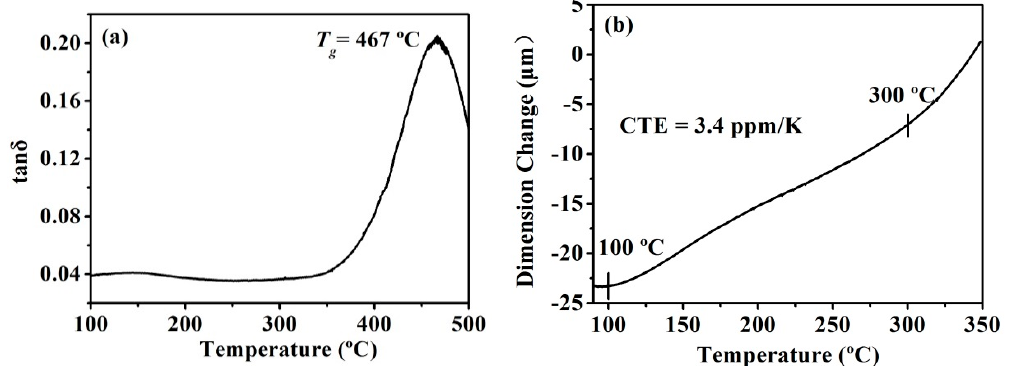
Figure 3. ( a ) DMA and ( b ) TMA curves of the 2,7-CPI film. Table 1. Thermal and mechanical properties of the 2,7 ‐ CPI film.